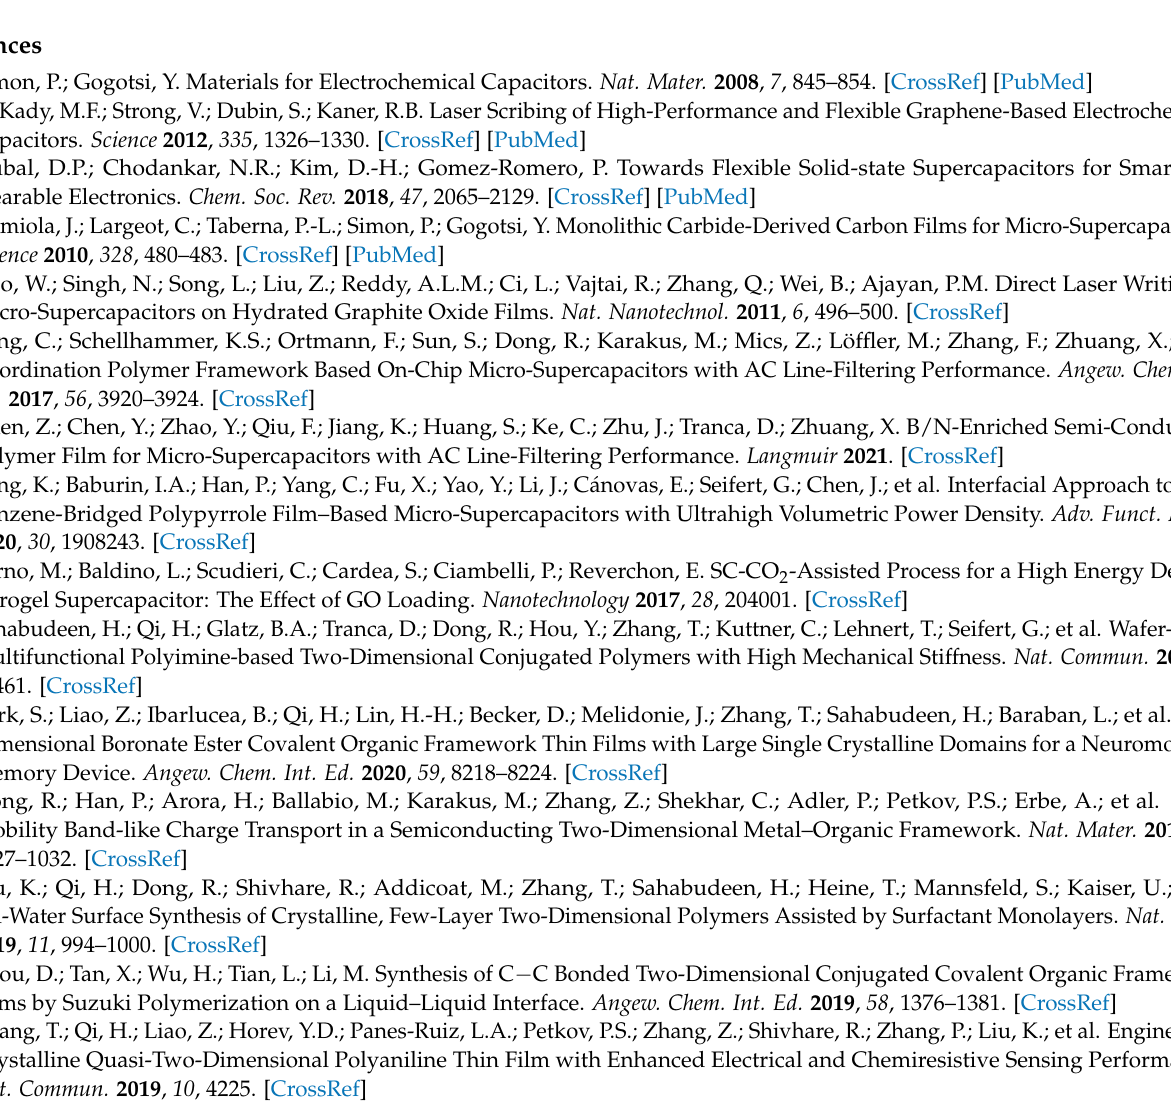
The parameters of Au electrodes, Figure S8–S10: CV curves, Table S1: Band structure, Table S2: Comparison performance of